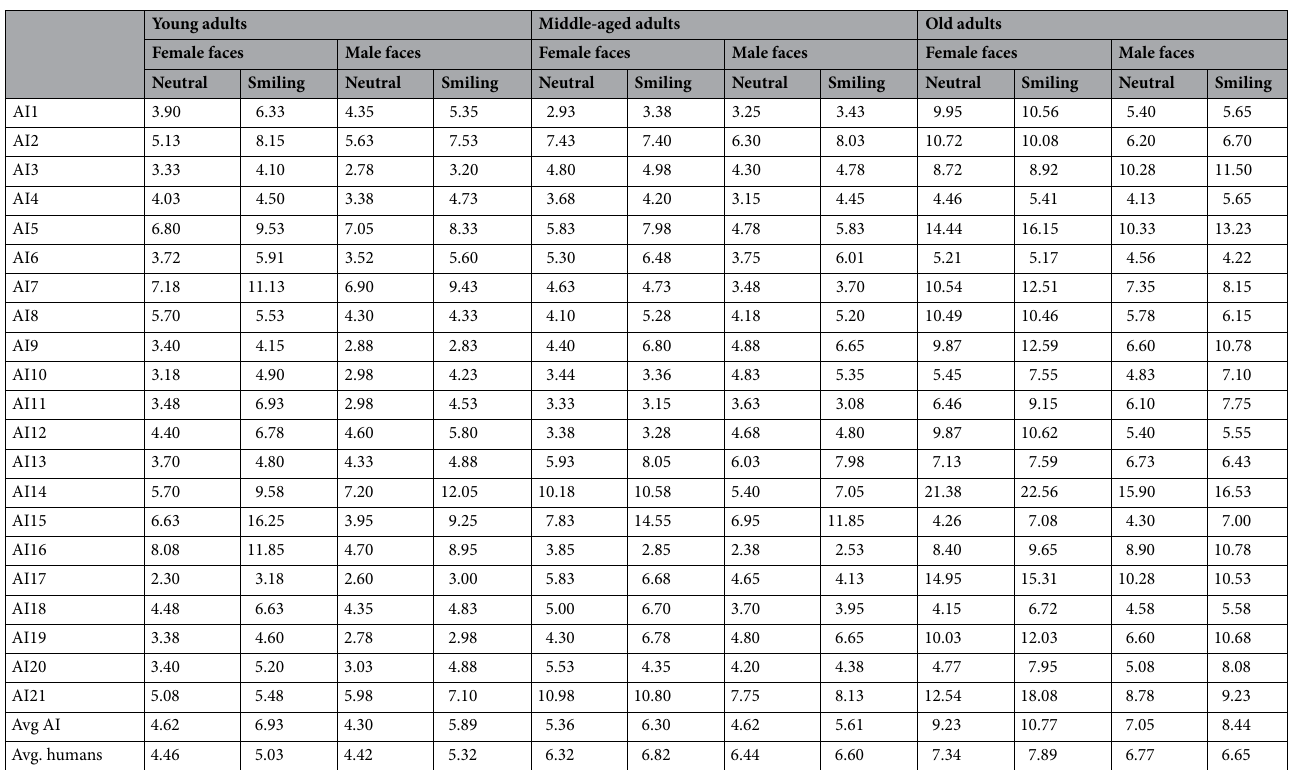
Table 2. Absolute age estimation accuracy (in years) of the different AIs compared to average human